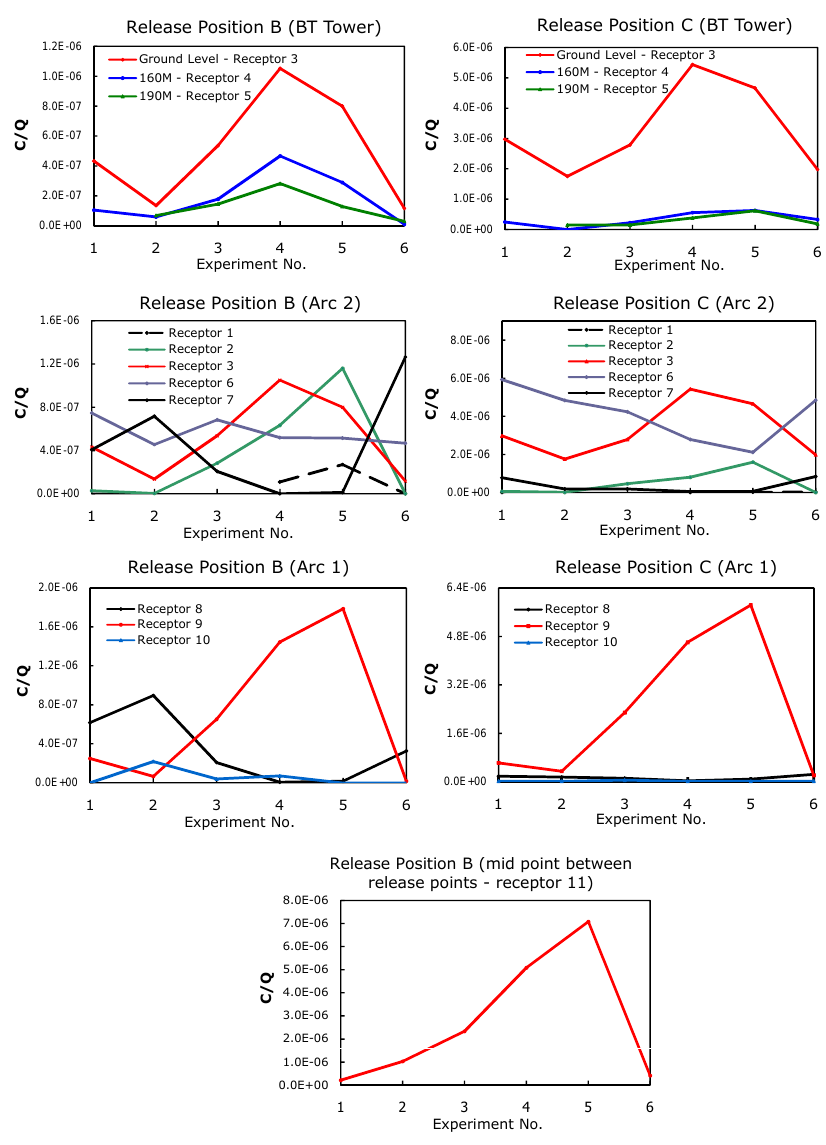
Fig. 4. Time-series of concentration for REPARTEE